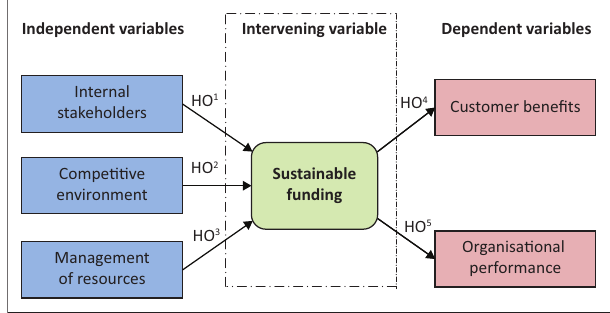
FIGURE 1: Proposed theoretical framework regarding sustainable funding for the public broadcaster in South